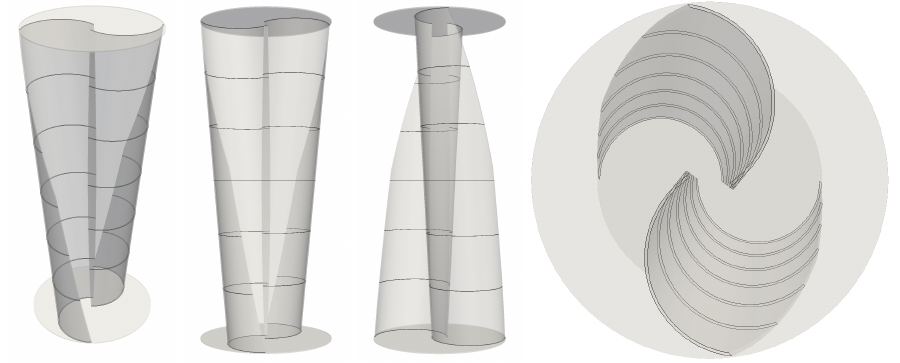
Figure 2. Seven cross-sections equally separated along the rotation axis for the SAVANT turbine. General 3D, front, lateral, and top views.